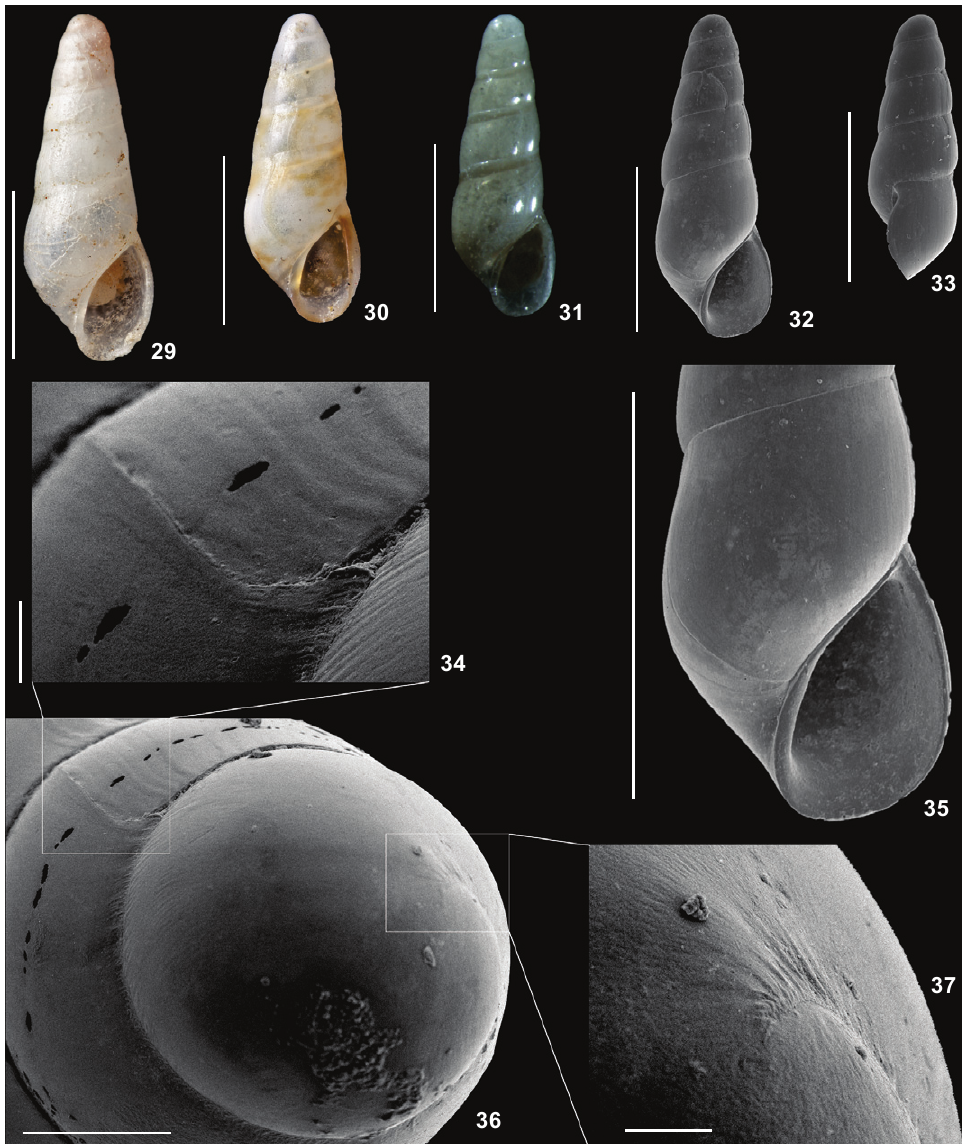
Figures. 29-37. (29-30) Fusceulima minuta , lectotype and paralectotype NHMUK 1885.11.5.2065, respectively; (31-37) Fusceulima cf. minuta : (31) MNRJ 17651; (32) MNRJ 17438; (33) MNRJ 17437; (34-36) IBUFRJ 19683; (37) MNRJ 17438. (29-33) whole shells; (34) detail of the terminal scar; (35) protoconch in apical view; (36) detail of suture at outset of protoconch; (37) last whorl. Scale bars: 29- 33, 37 = 1.0 mm, 34, 36 = 20 µm, 35 = 50 µm. Images (29-30) courtesy of Harry Taylor, NHMUK photographic